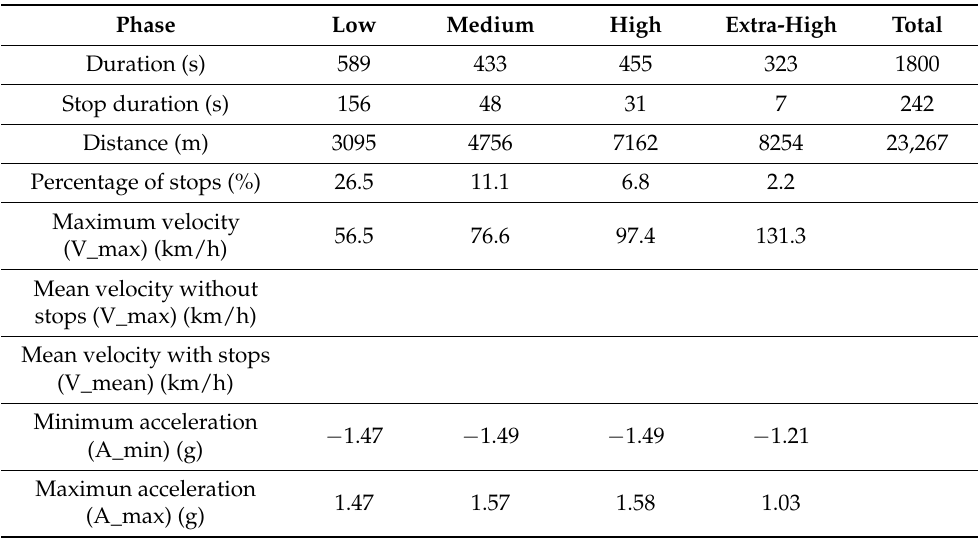
Table 1. Driving characteristics for scenario 1 (WLTP